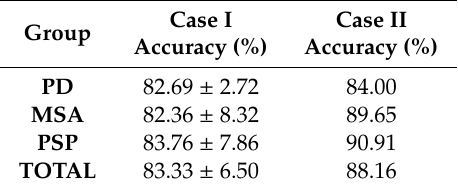
Table 3. Results of the decision support system for each group of patients separately and in total. The result is provided for two cases: when all recordings are included in the analysis (Case I) and when only recordings with the same score from both raters are included in the analysis (Case II).